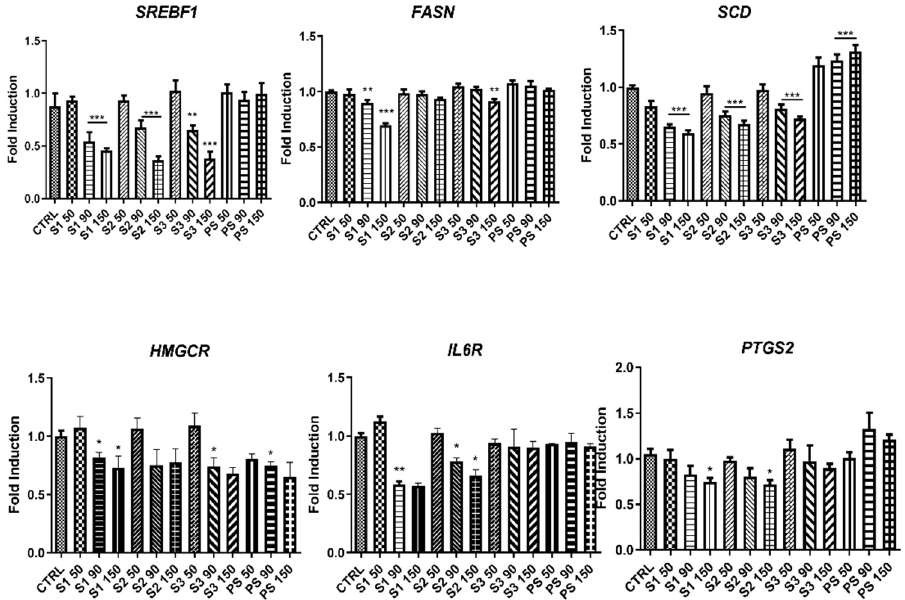
Figure 5. Seed-derived SFE extracts regulate lipid metabolic targets in the DLD1 CRC cell line. Asterisks indicate statistically significant differences ( p < 0.05 (*); p < 0.01 (**); p < 0.005 (***)) relative to the control non-treated cells (3 replicates, three independent experiments).